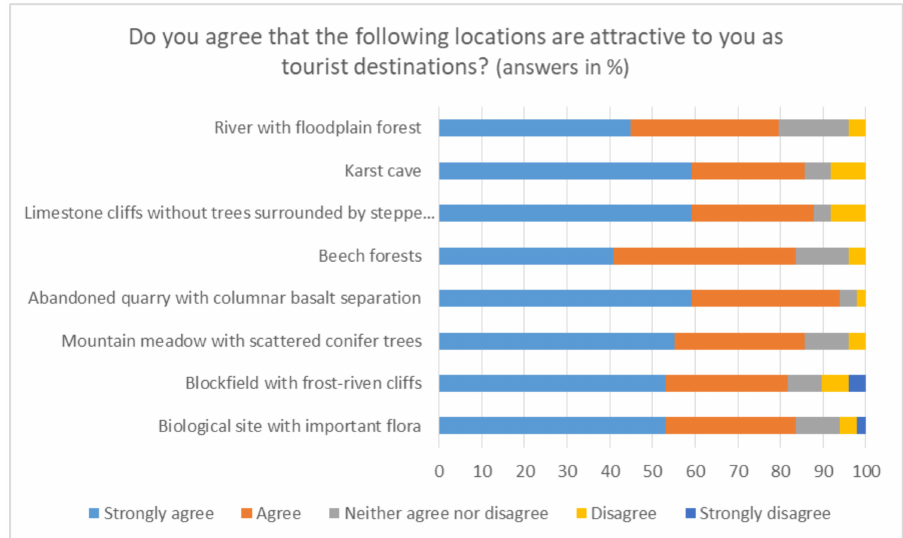
Figure 4. The results of the third group of questions: there are no big differences between the choice of destinations.